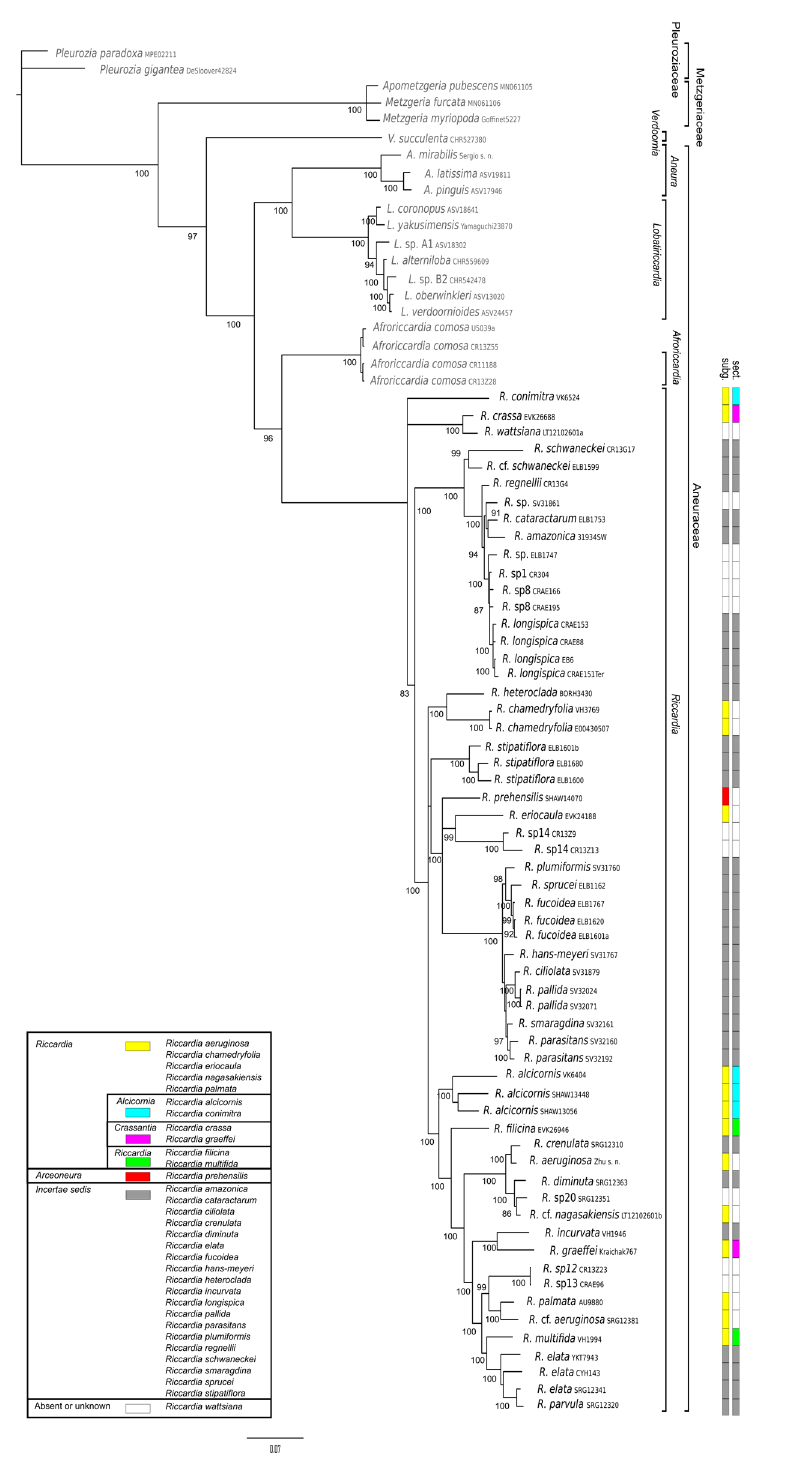
Fig. 1. The 50% majority-rule consensus of the trees generated by Bayesian Inference (BI) of the combined psb A -trn H, rps 4 and trn L - F dataset. Posterior probability percentages above 80% are indicated under each node. Species names appear in italics, followed by the corresponding voucher number. Outgroup labels appear in light grey. Infra-generic divisions (sub-genera and sections) of Riccardia according to Nebel (2016) are reported in front of each name. The corresponding colour scheme for each sub-generic division is shown in the bottom left proportion of the